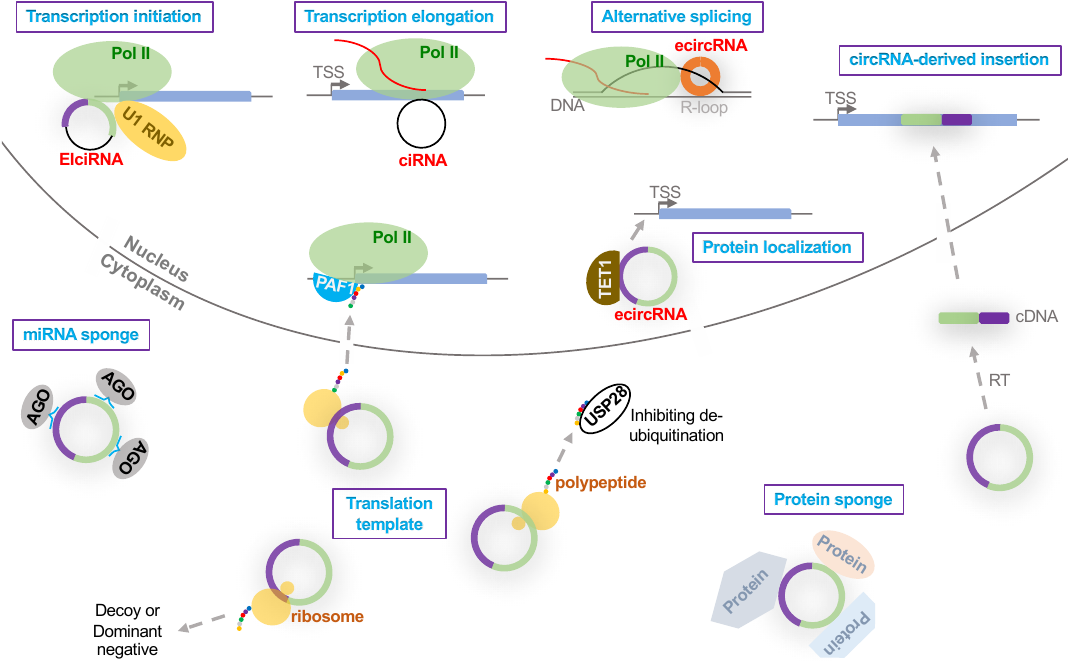
Figure 2. Potential functional modes of circular RNAs. The biological processes regulated by circular RNAs are highlighted in purple boxes. Red lines depict nascent RNA transcripts. TSS, transcription starting site. Pol II, RNA polymerase II. PAF1, RNA polymerase II-associated factor 1 homolog. AGO, Argonaut proteins. TET1, Tet methylcytosine dioxygenase 1. USP28, ubiquitin carboxyl-terminal hydrolase 28. RT, reverse transcription. miRNA, microRNA.